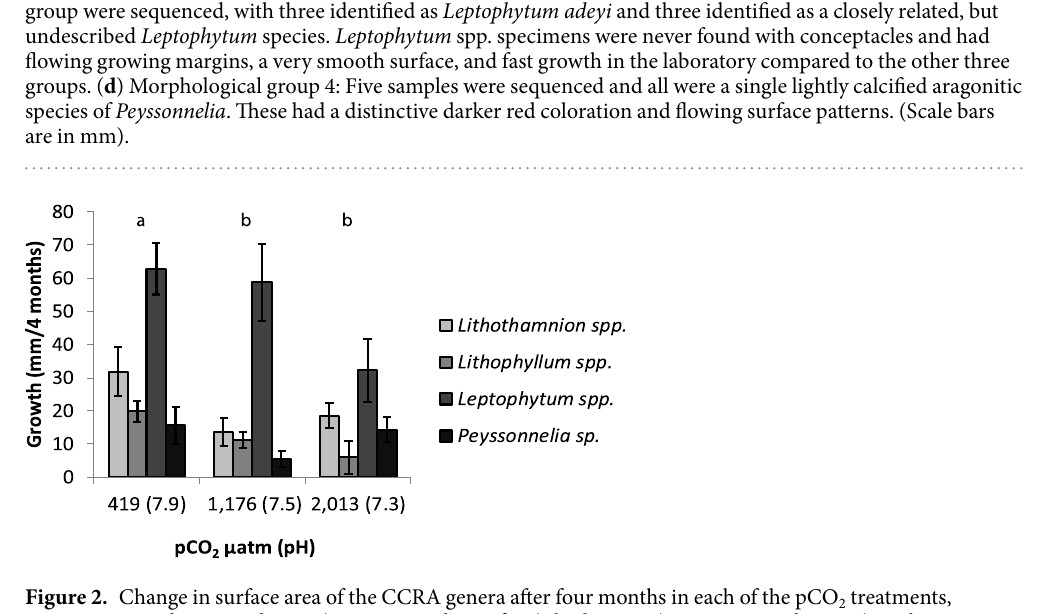
Figure 2. Change in surface area of the CCRA genera after four months in each of the pCO 2 treatments, representing ambient conditions (419 µ atm and pH of 7.9), high pCO 2 (1,176 µ atm and 7.5 pH), and extreme pCO 2 (2,013 µ atm and 7.3 pH). This data is shown to demonstrate that the pCO 2 treatments had an effect on the CCRA. Letters above bars denote significant differences in growth considering all four